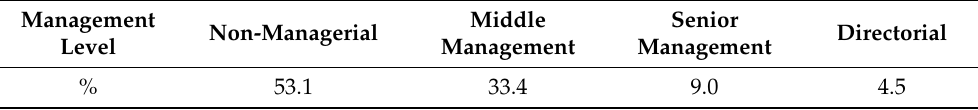
Table 2. Management level of respondents (n =